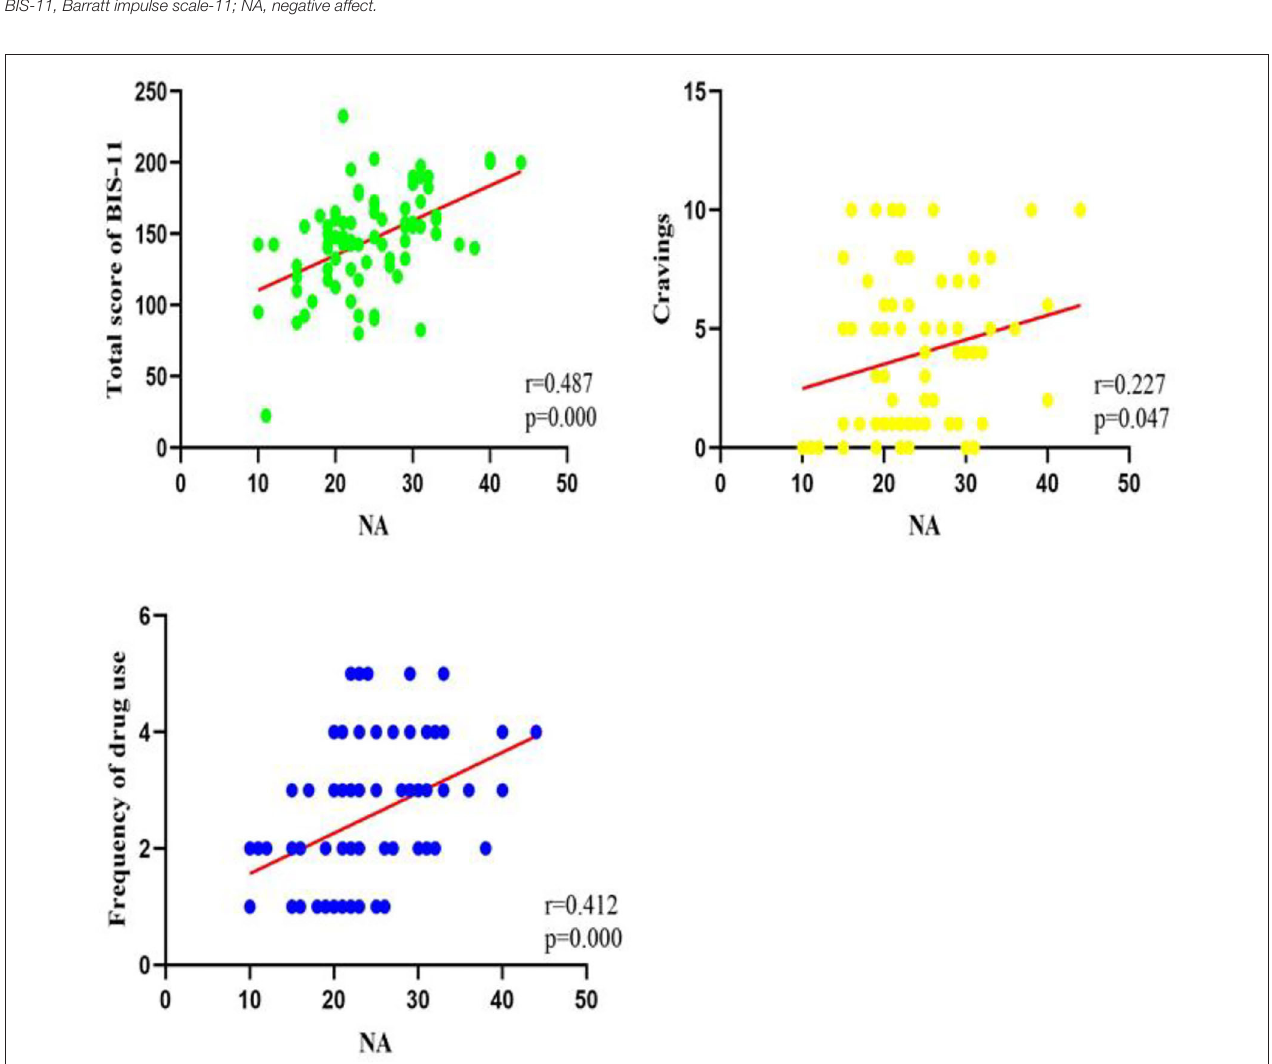
FIGURE 1 | Correlations of total score of BIS-11, cravings, frequency of drug use, and total score of NA ( N = 77).